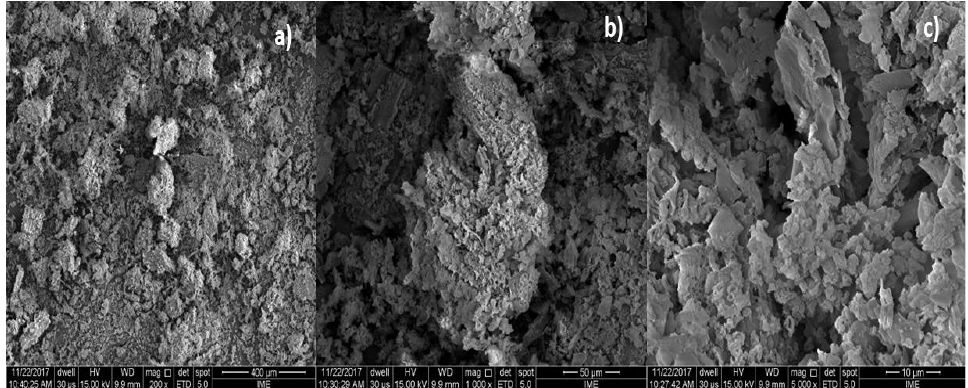
Figure 7. SEM of hydro-chars obtained by hydrothermal processing of corn stover at 250 °C, bio- mass/H 2 O ratio of 1:10, 120 min (MAG: 200× ( a ); MAG: 1000× ( b ); MAG: 5000× ( c )).